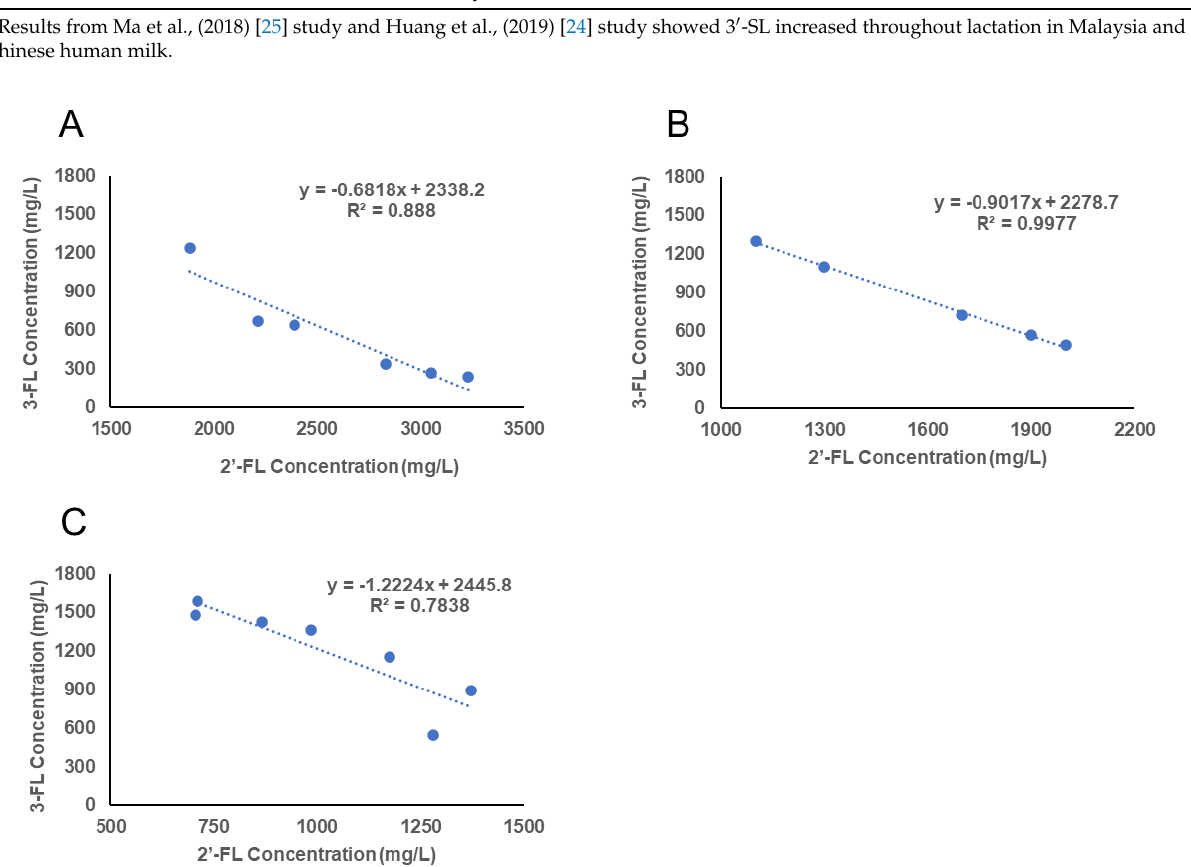
Figure 1. Correlation between 3-fucosyllactose (3-FL) concentration and 2 ′ -fucosyllactose (2 ′ -FL) concentration throughout lactation . ( A ) Collective data on the studies carried out between 1999–2015 from Thurl et al., 2017 [2]). ( B ) Data reported by Austin et al., 2016 [32]; ( C ) by Ma et al., 2018 [25]).